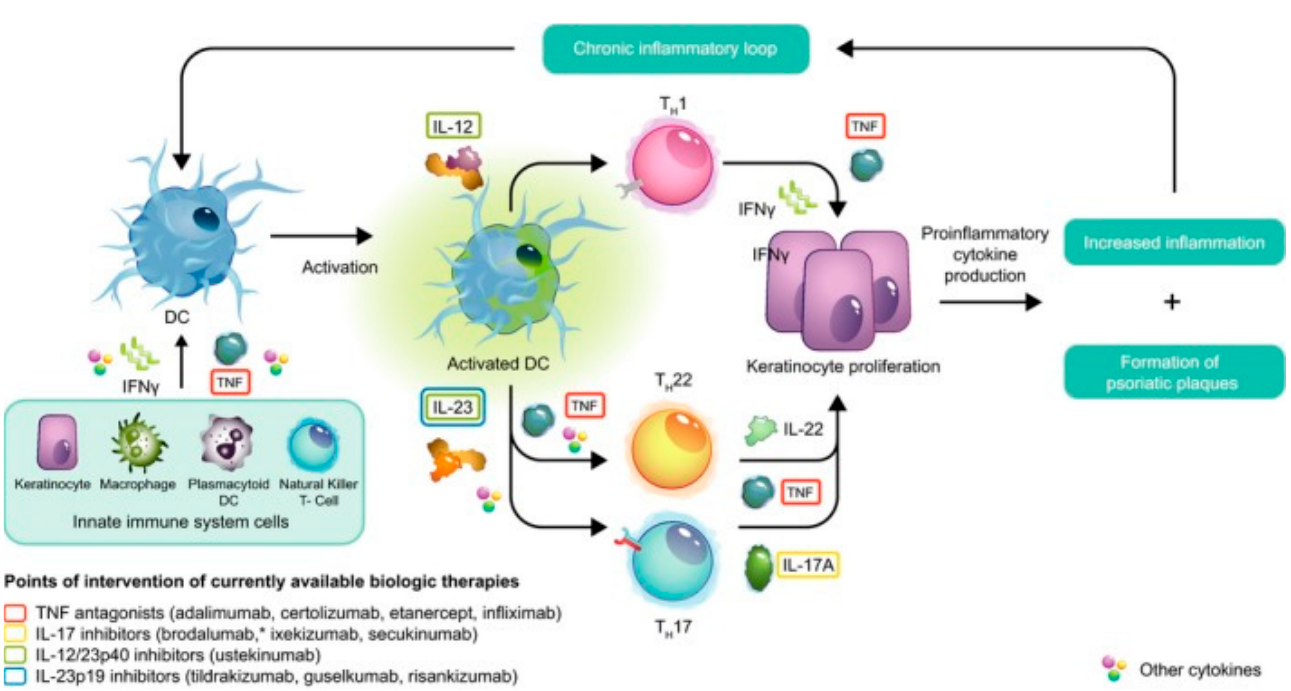
Figure 1. Overview of Psoriasis Molecular Pathogenesis and Targeted